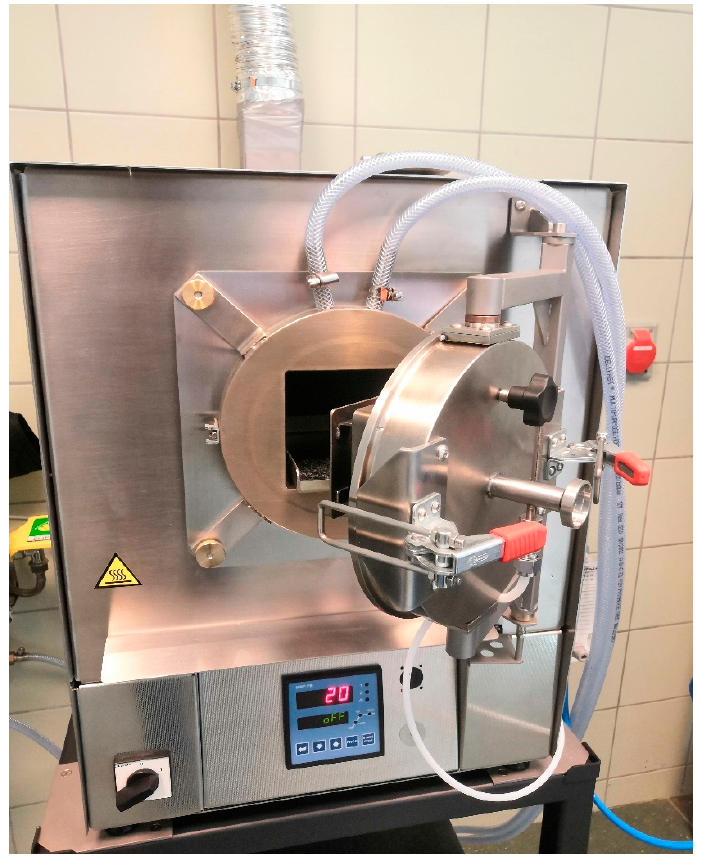
Figure 1. Pyrolysis retort furnace.